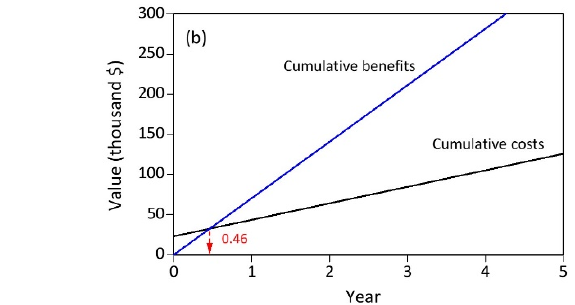
Chromatogram of phenol intermediate using GC-MS analysis; Table S1: Bandgap energy values of the samples. References [42–44,86] are cited in the supplementary